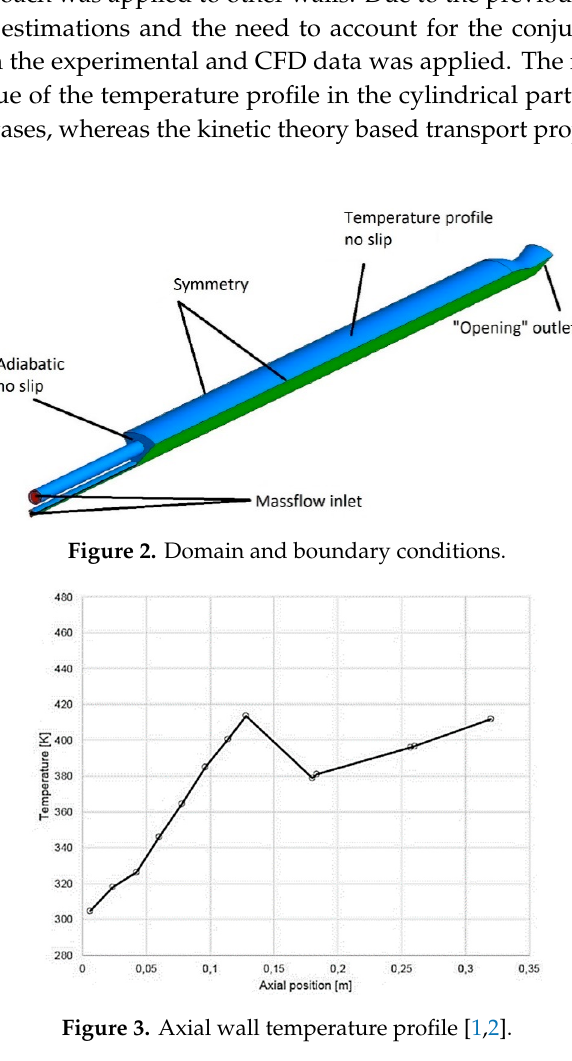
Table 1. Mesh independence study data.